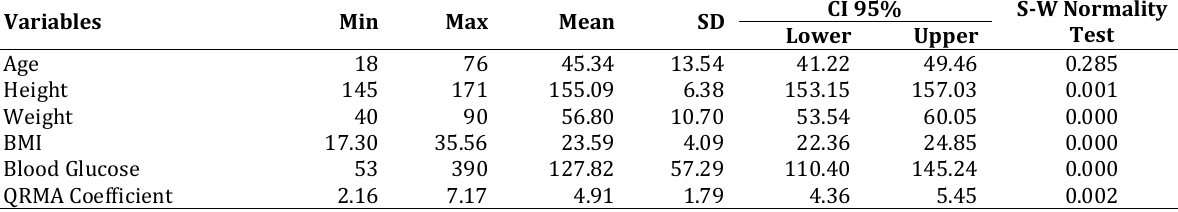
Table 2. Distribution of the Age, Height, Weight, BMI, Blood Glucose and QRMA Coefficients, 2017 (n =44) Variables Age